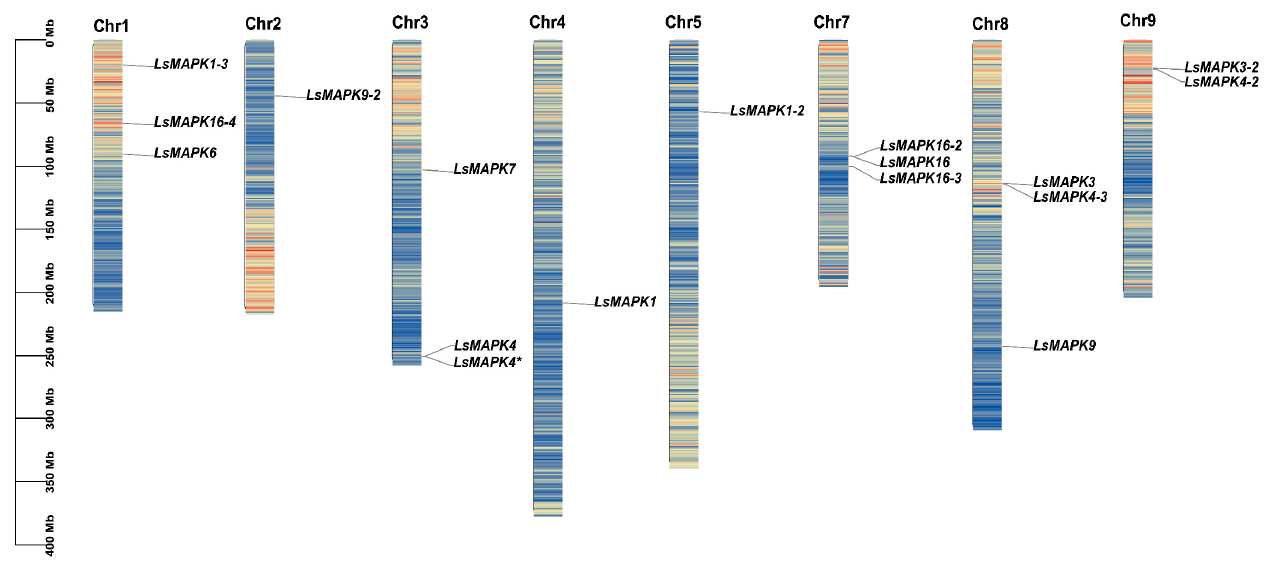
Figure 1. Chromosomal location of LsMAPKs . The chromosome number is indicated at the top, and the scale on the left represents the chromosome size. Without LsMAPK localization, chromosome 6 is not shown. Table 1. Physical and chemical aspects of LsMAPKs .